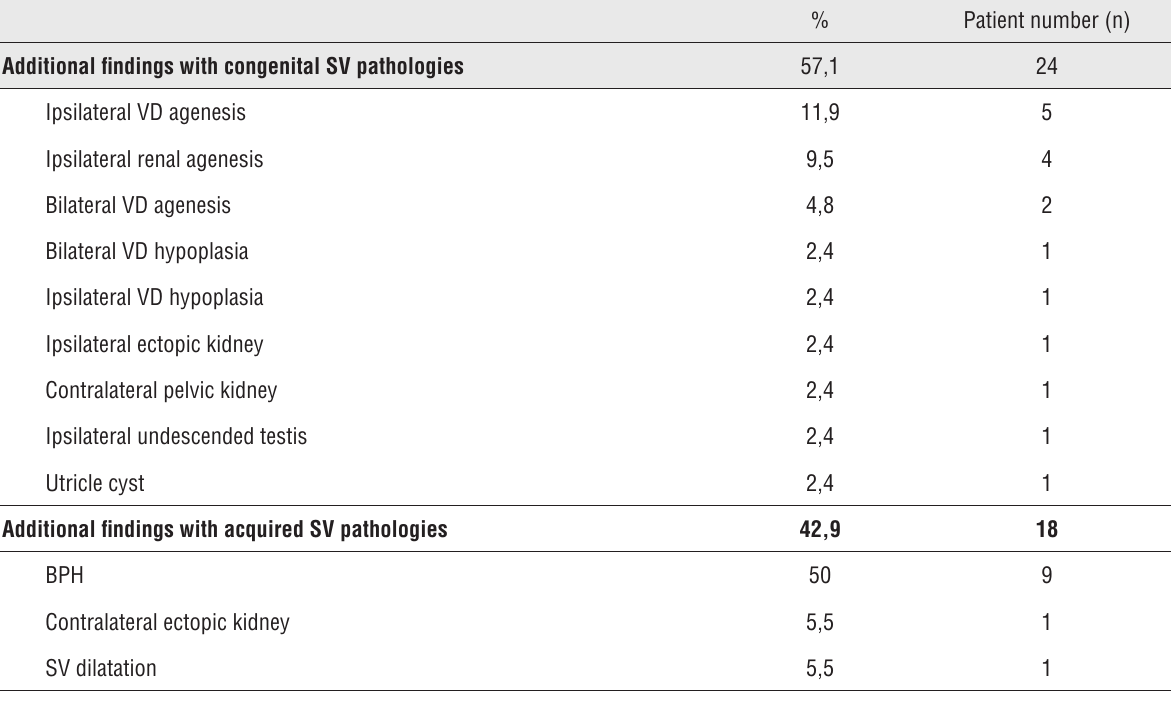
Table 7 - Additional findings in patients with congenital and acquired sv